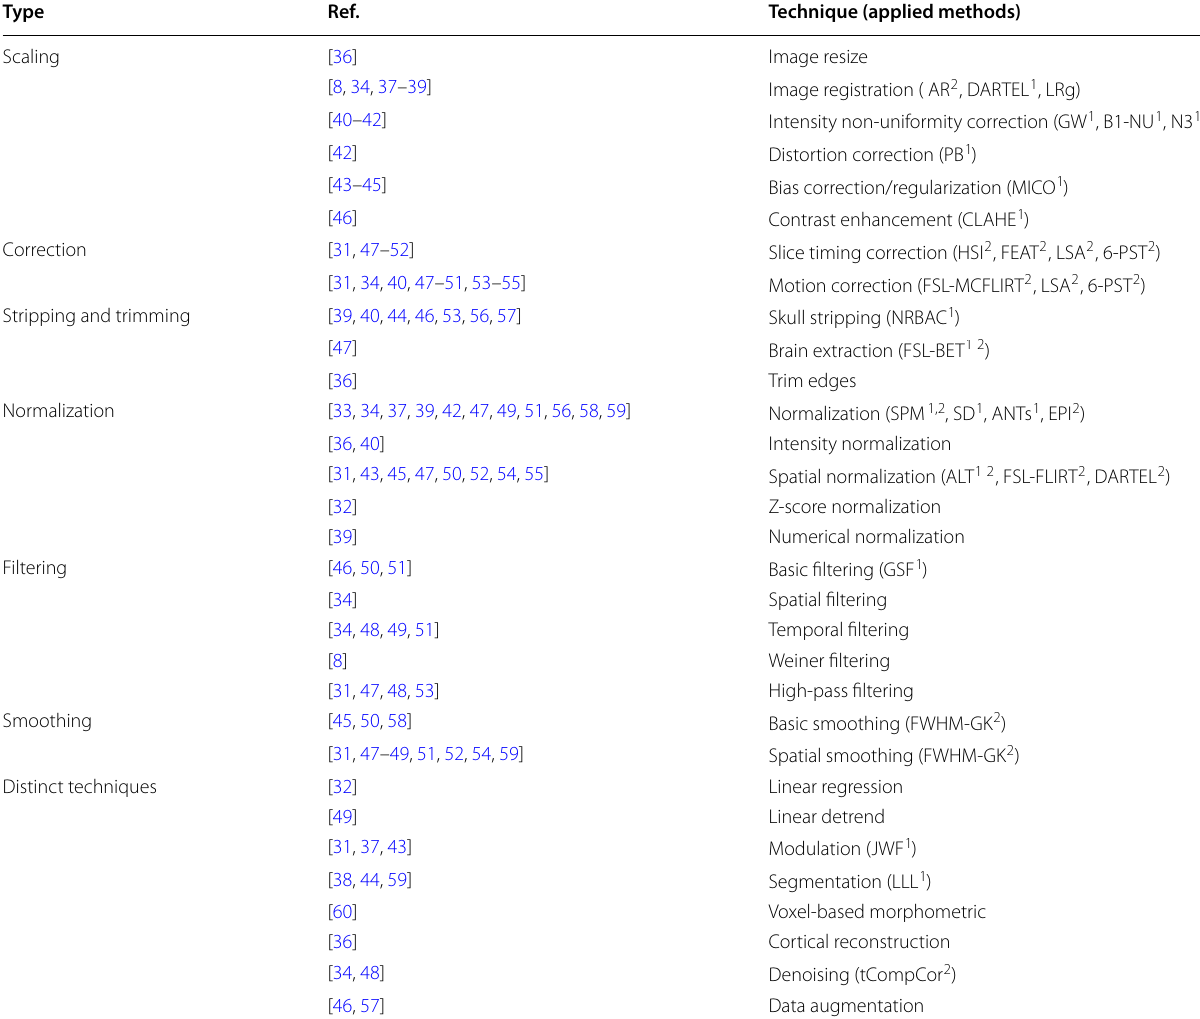
Table 1 Data pre‑processing techniques applied to MRI and fMRI